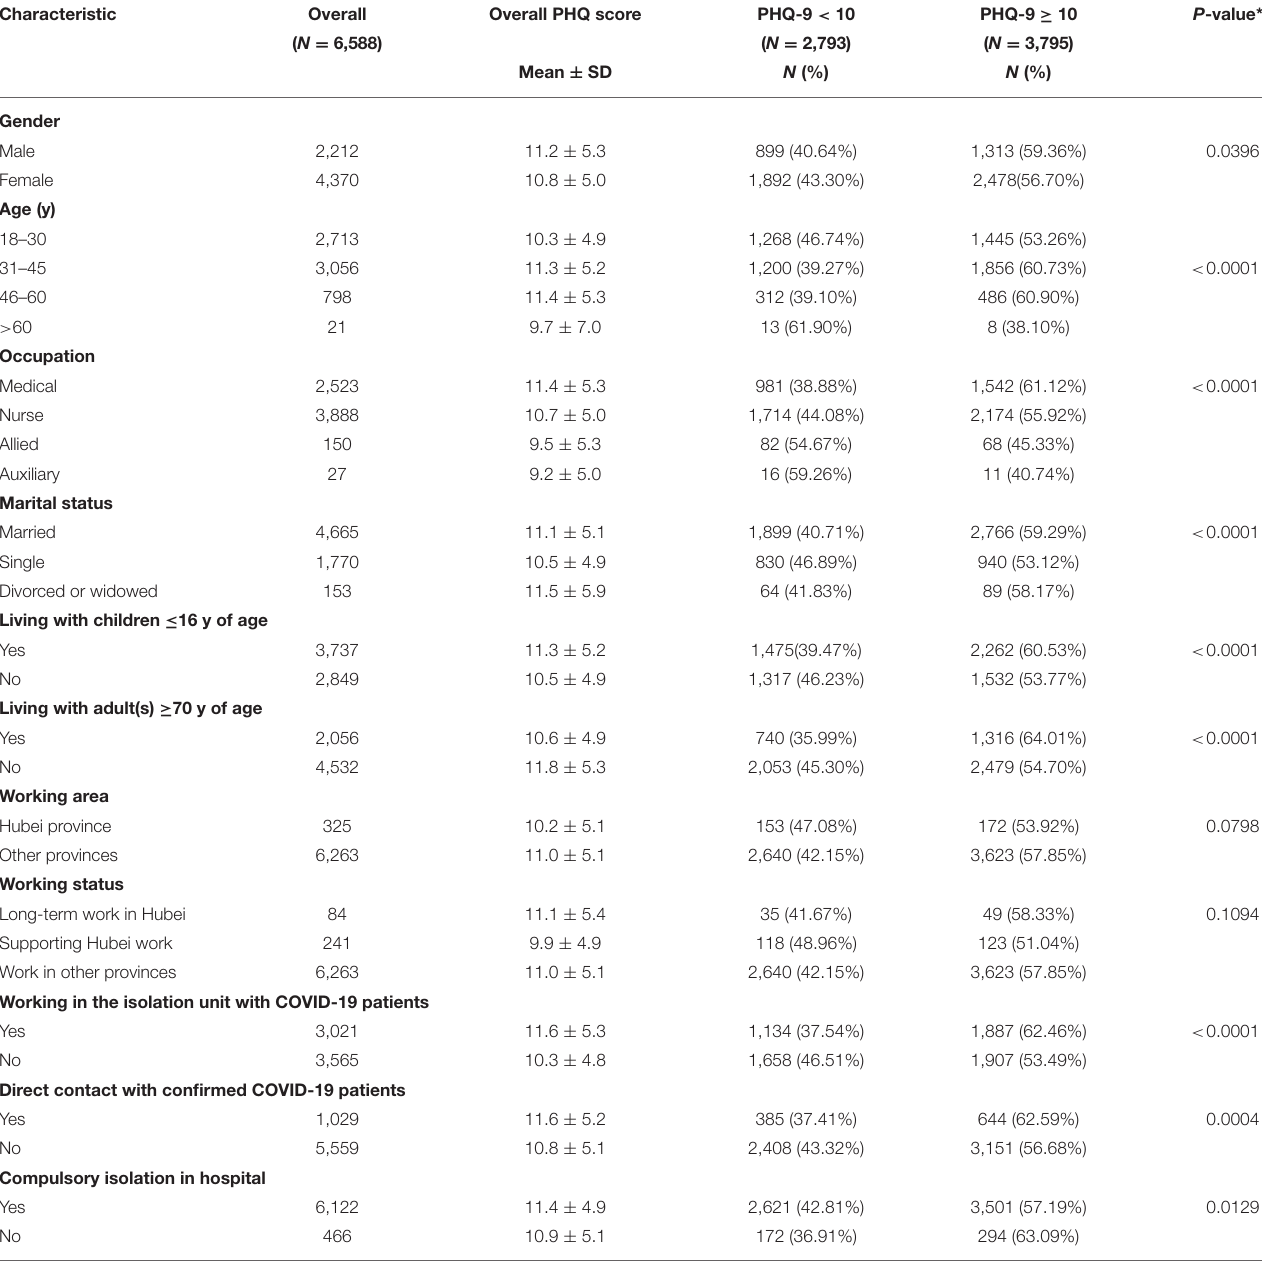
TABLE 2 | Univariate analysis results between the PHQ-9 < 10 and PHQ-9 ≥ 10 groups.